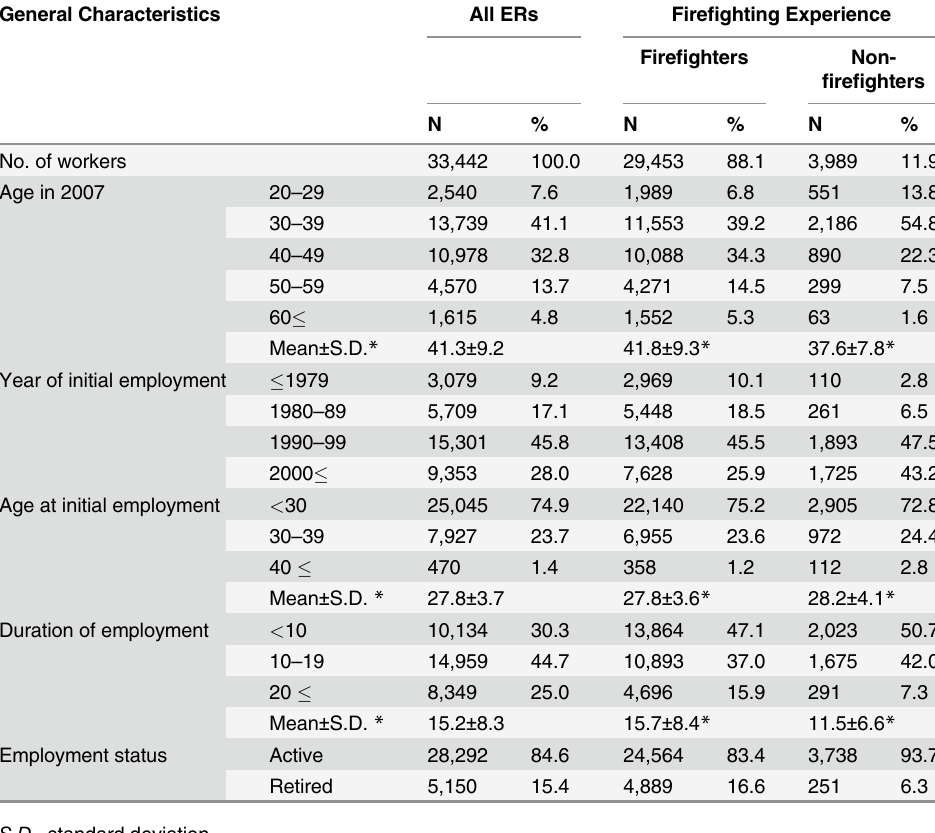
Table 1. General characteristics of emergency responders